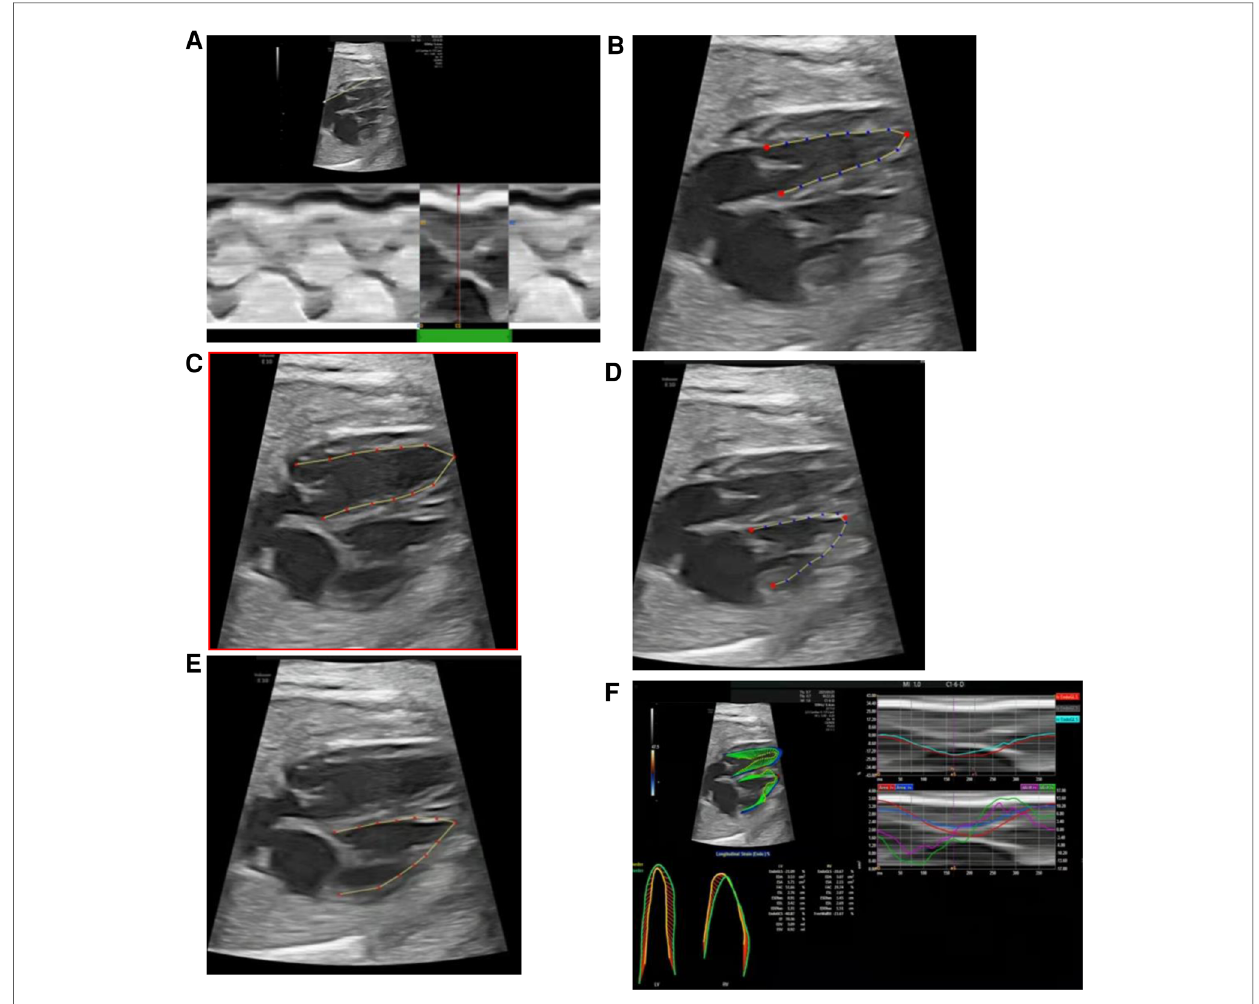
FIGURE 2 fetalHQ speckle tracking software measures left and right ventricular parameters. ( A ) Selection of one cardiac cycle (M-Mode); ( B ) de fi ning of left ventricular end-systolic endocardial tracing; ( C ) de fi ning of left ventricular end-diastolic tracing; ( D ) de fi ning of right ventricular end-systolic endocardial tracing; ( E ) de fi ning of right ventricular end-diastolic tracing; ( F ) obtaining of results and